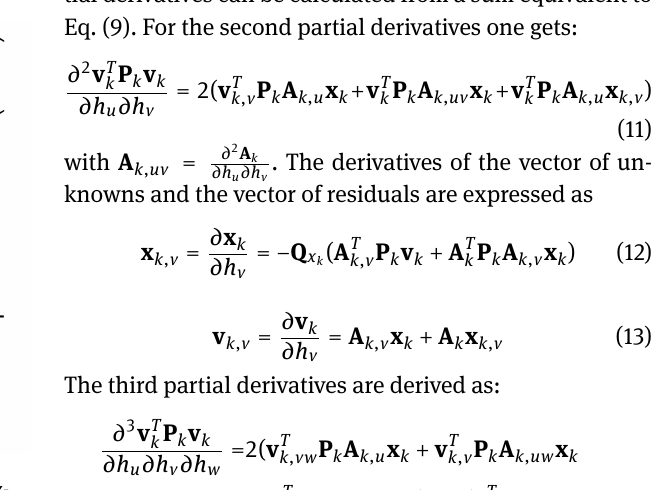
Figure 1: Contour plot of the cost functions from Eq. (4) for the ex- ample data set of three satellites.